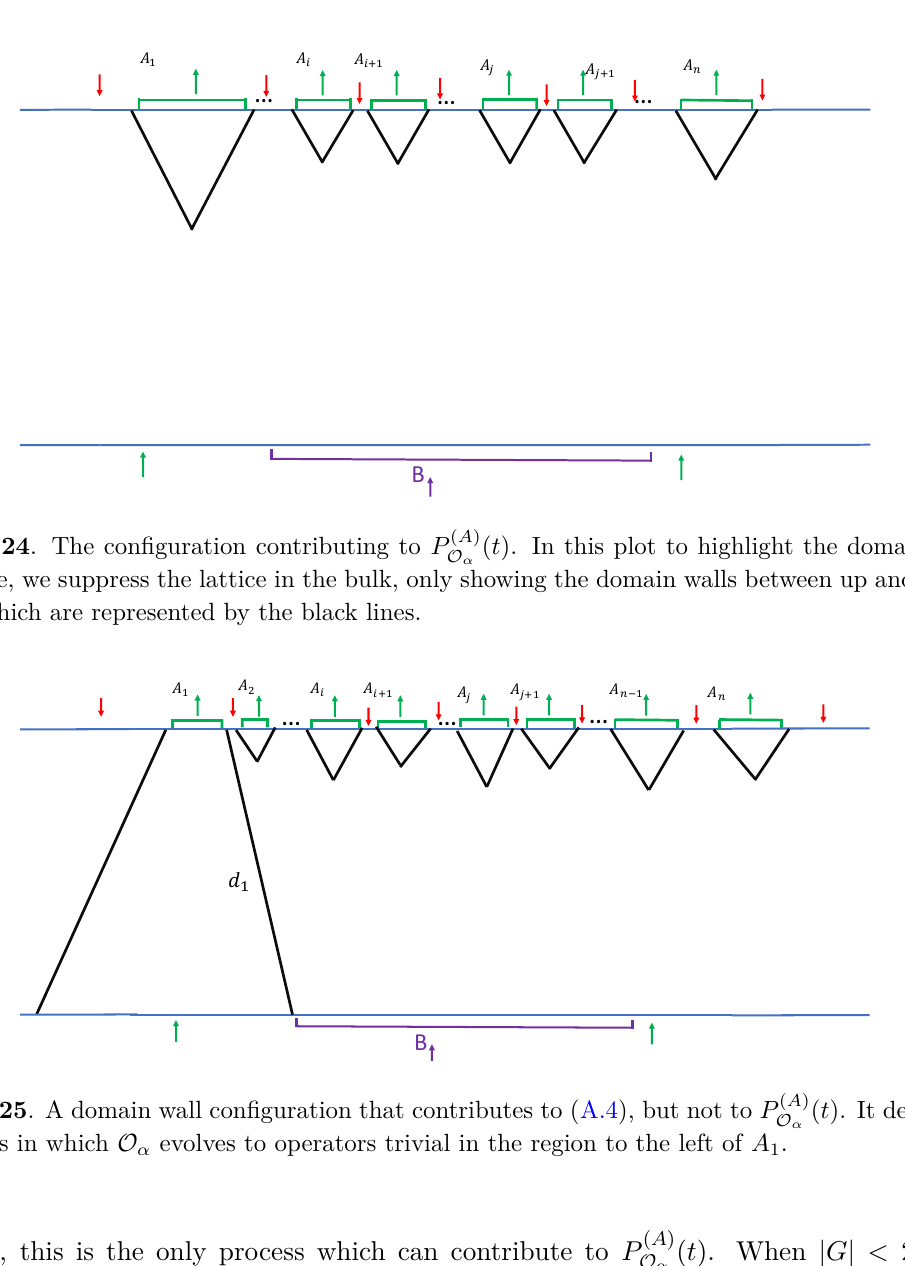
( t ) . It describes O α